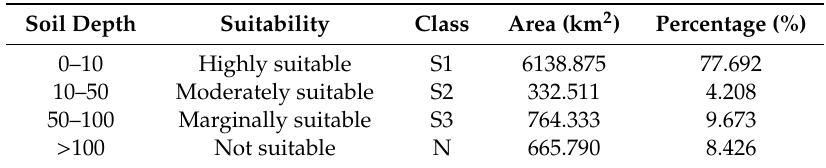
Table 5. Suitability based on soil depth.